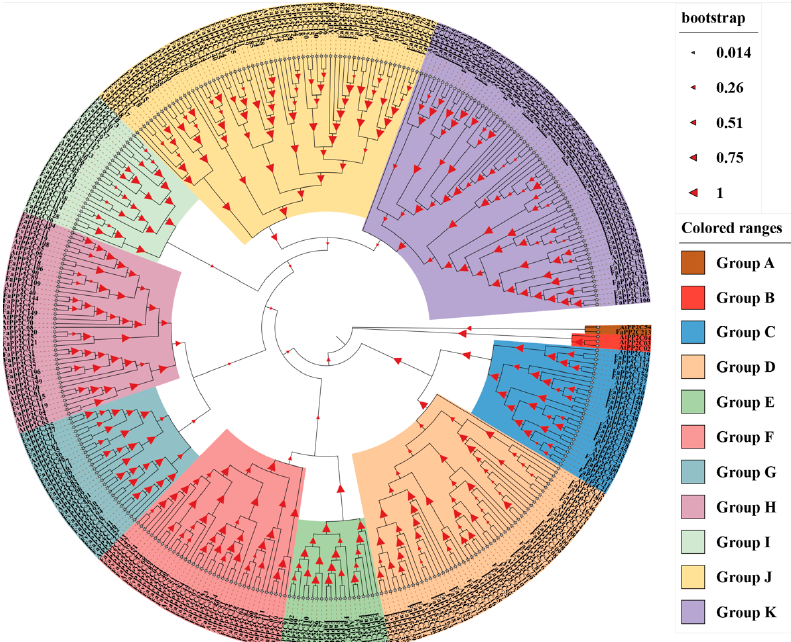
Figure 1. Phylogenetic analysis of the PP2C gene family from F. vesca , F. ananassa , and A. thaliana . Note: Phylogenetic trees were constructed using the PP2C protein sequences. Maximum parsimony was adopted, and the bootstrap value was set to be equal to 1000.